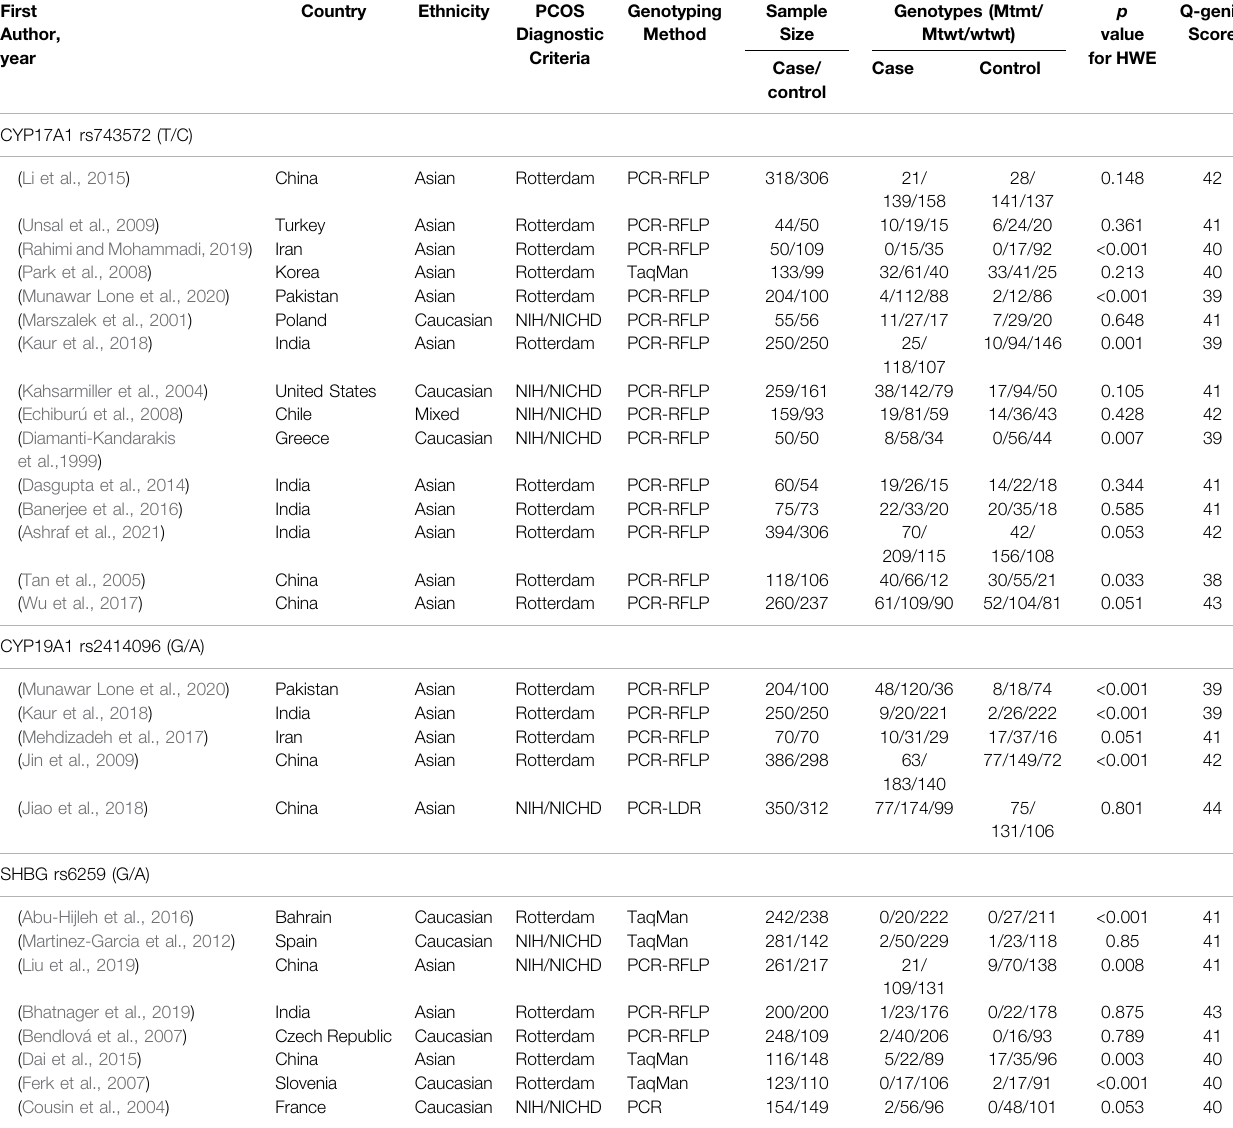
TABLE 1 | The characteristics of included studies for this